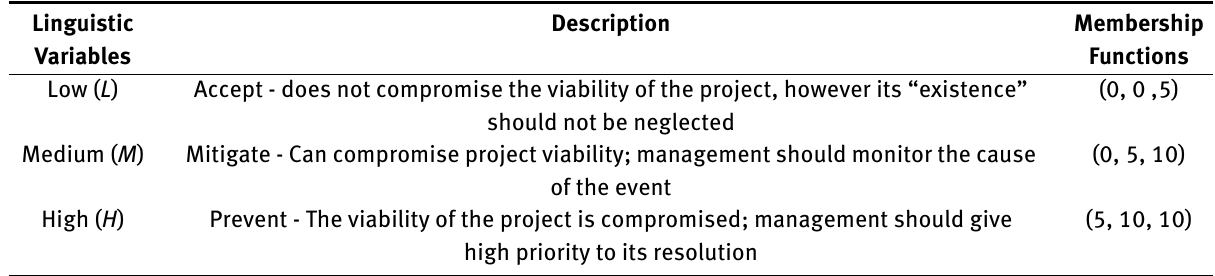
Table 4: Linguistic Variables for Risk Variables R- (Primary) or LR- (Integrated) and Membership Functions. Linguistic